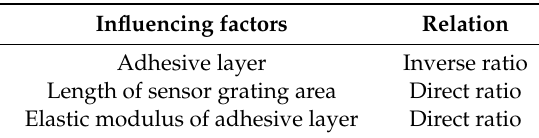
Table 1. Analysis of influencing